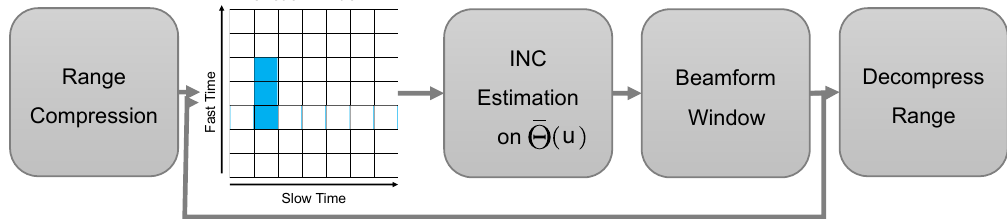
Figure 10. A Pulsed-RFI MVDR mitigation with DBF. A mitigation of N − 1 interferers per window is possible.